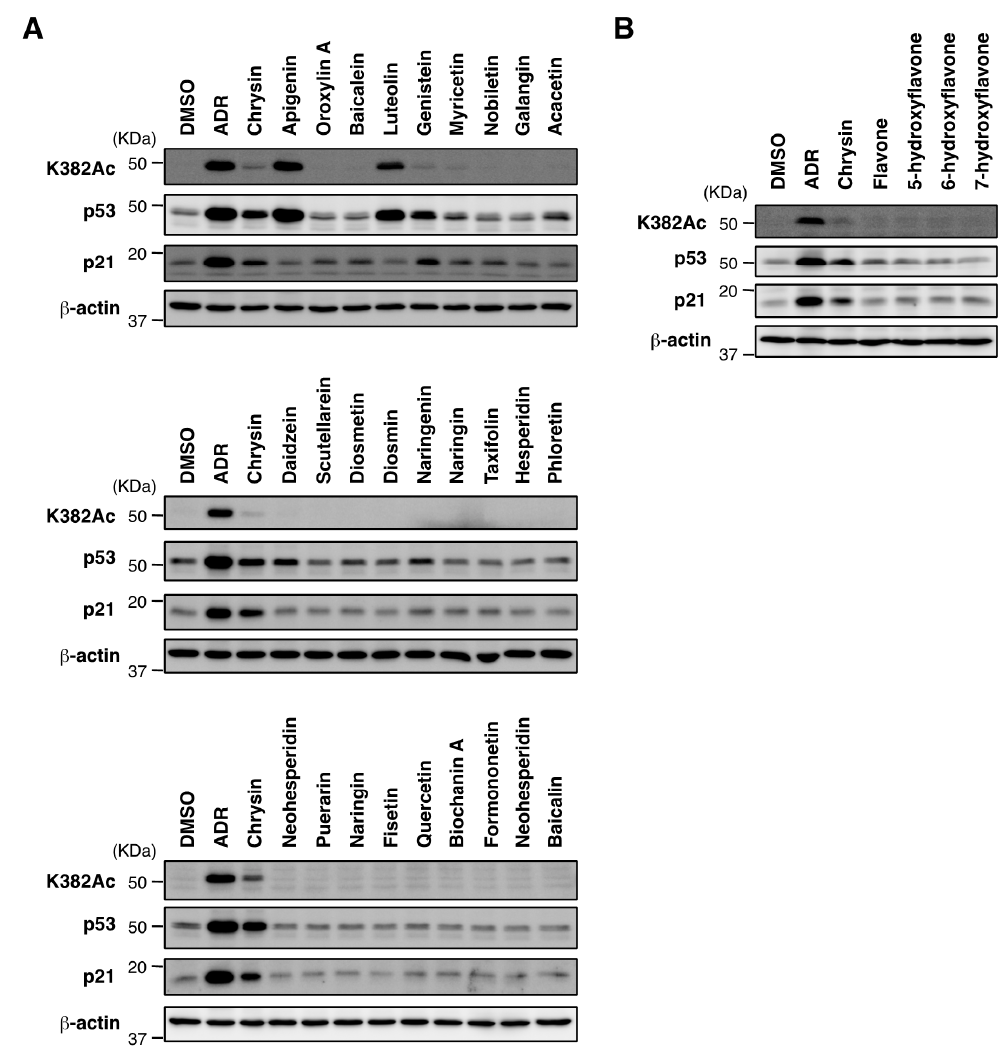
Figure 4. Biological evaluation of p53 activation by flavonoids in MCF7 cells. ( A ) MCF7 cells were treated with ADR (0.3 μ M), chrysin (40 μ M), or 26 flavonoids (40 μ M) for 8 h. Cell lysates were immunoblotted with the indicated antibodies. ( B ) MCF7 cells were treated with ADR (0.3 μ M), chrysin (40 μ M), or 4 flavones (40 μ M) for 8 h. Cell lysates were immunoblotted with the indicated antibodies.